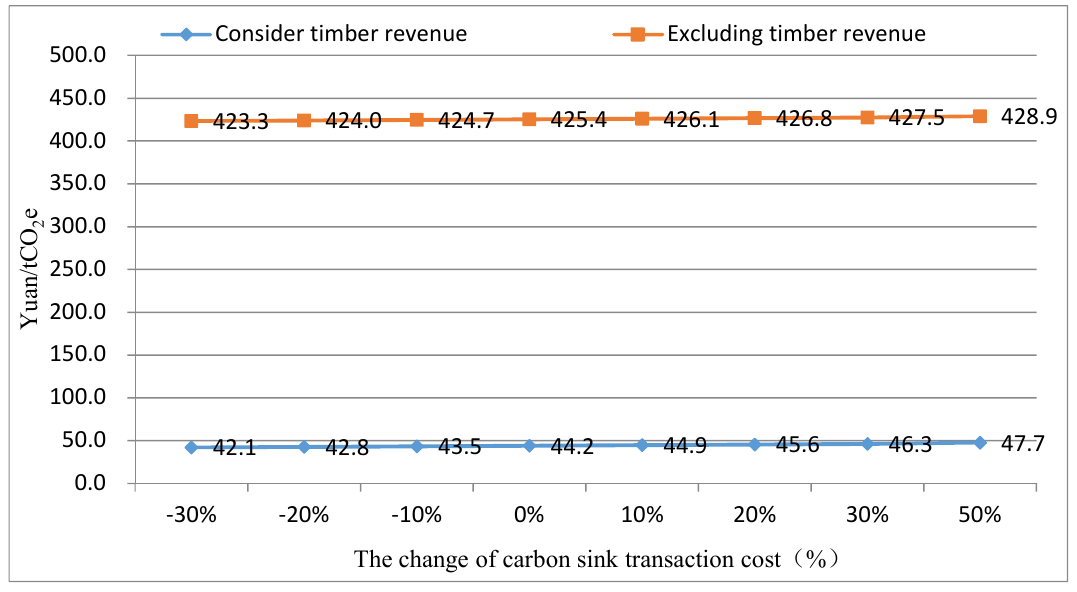
Figure 2. The carbon sink cost under different carbon sequestration transaction costs.